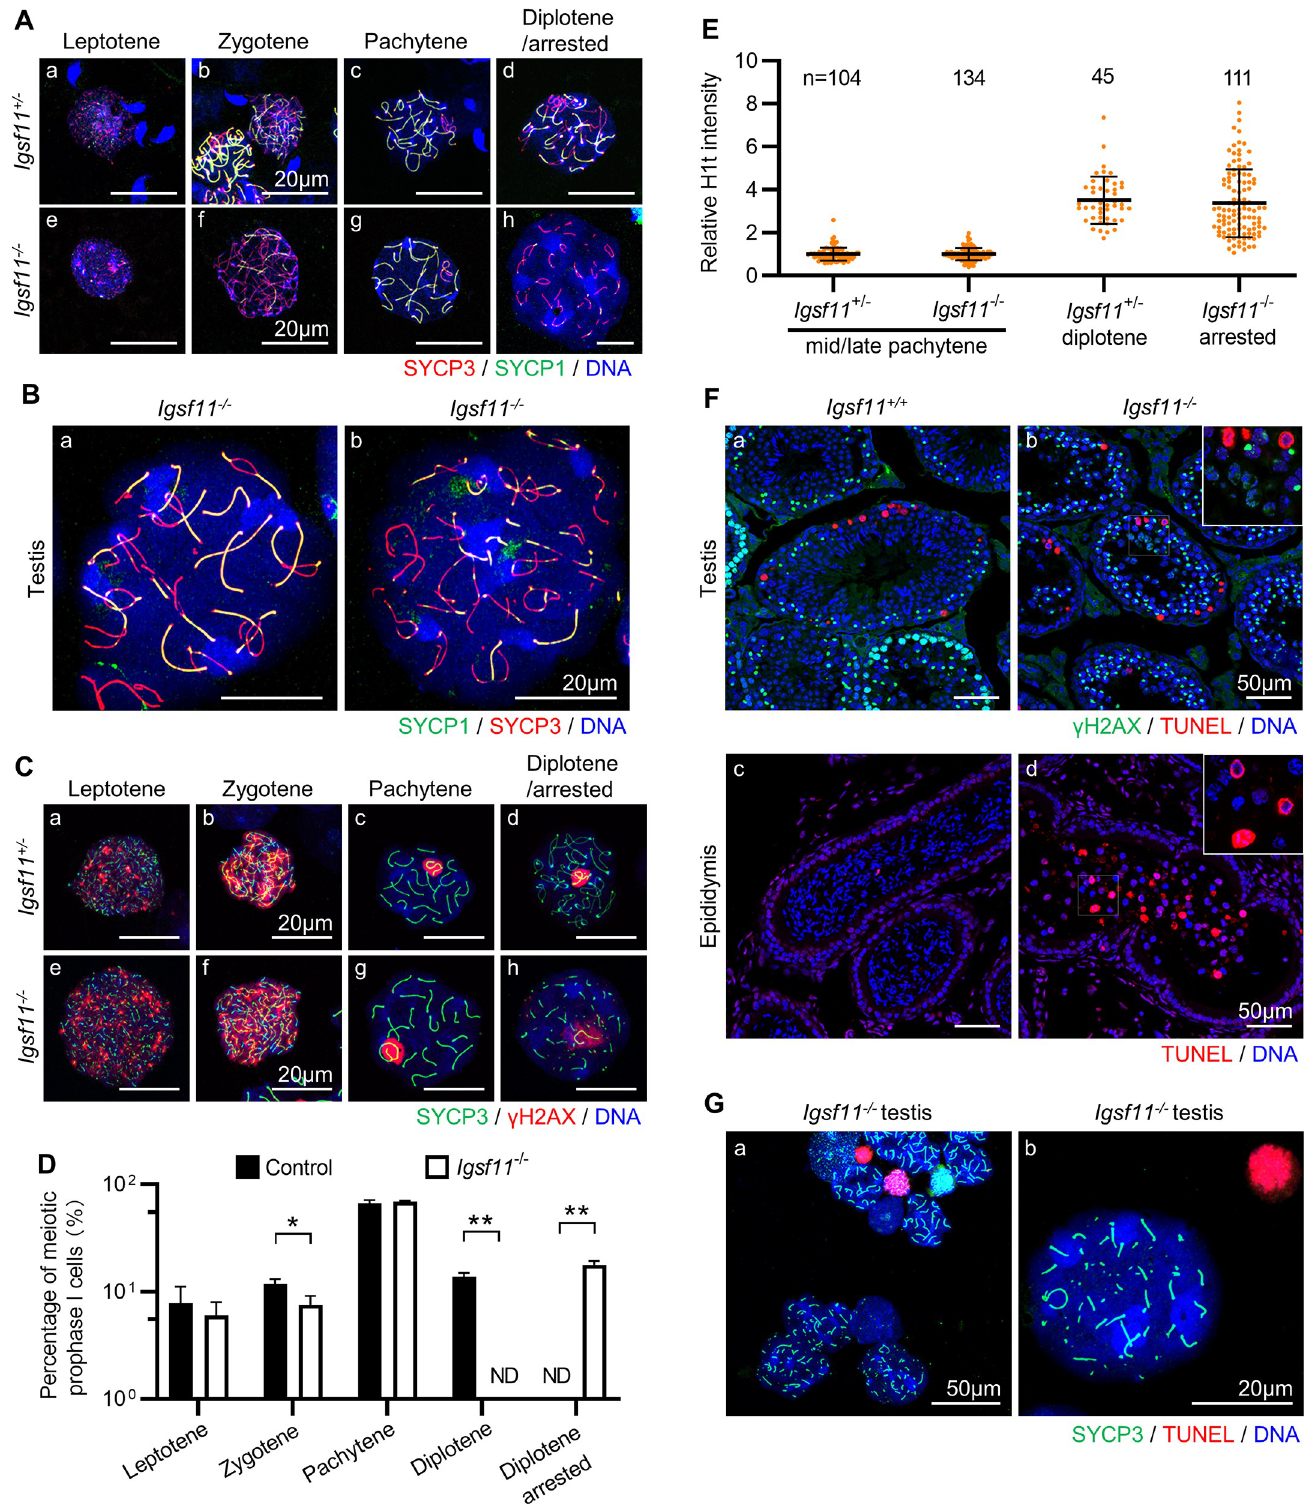
Fig 5. Spermatocytes of Igsf11 deficient mouse are arrested at diplotene. (A-C) Comparison of the synaptonemal complex assembly (A and B) and DSBs repair (C) in spermatocytes of the control ( Igsf11 +/- ) and mutant ( Igsf11 -/- ) mice using SYCP3, SYCP1, and γ H2AX as markers. Representative confocal images of diplotene stage Igsf11 mutant spermatocytes were shown in Fig 5B. (D) Statistics of meiotic prophase I spermatocytes within meiotic spread samples. See S2 Table